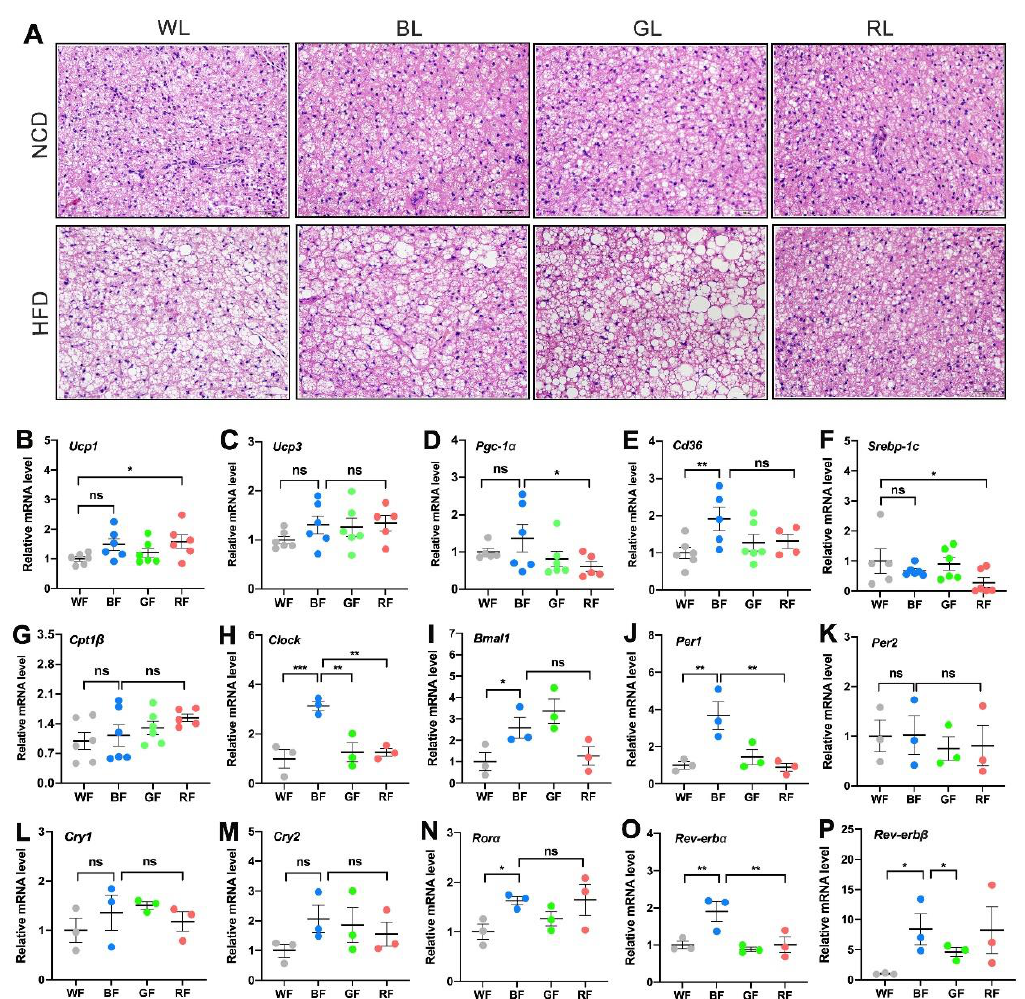
Figure 4. Influences of monochromatic light exposure on BAT whitening and expression of circadian genes in BAT. ( A ) H&E staining of BAT (scale: 50 µ m). ( B – G ) Relative mRNA expression levels of genes involved in lipid metabolism in the BAT, including Ucp1, Ucp3, Pgc-1 α , Cd36, Srebp-1c, Cpt1 β ( n = 6). ( H – P ) Relative mRNA expression levels of Clock, Bmal1, Per1, Per2, Cry1, Cry2, Ror α , Rev-erb α , and Rev-erb β in the BAT ( n = 3). The results are presented as the means ± SEM. * p < 0.05, ** p < 0.01, *** p < 0.001.